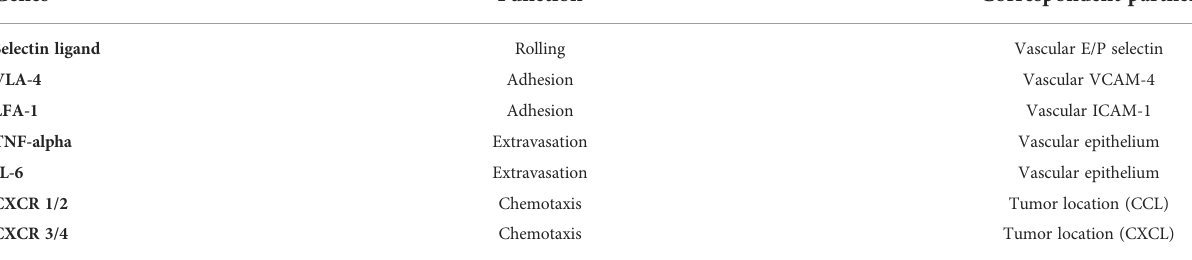
TABLE 3 TIL in fi ltrating